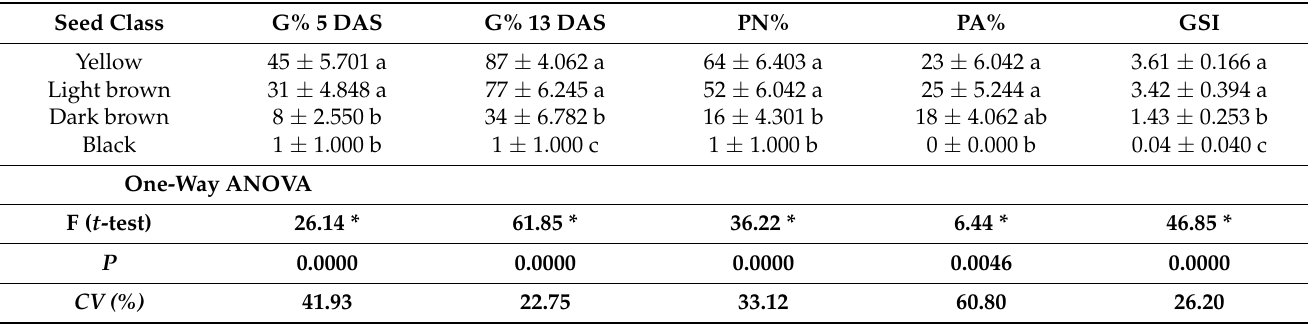
Table 2. Germination percentage at five days after sowing (G% 5 DAS), germination percentage at thirteen days after sowing (G% 13 DAS), percentage of normal seedlings (PN%), percentage of abnormal seedlings (PA%) and GSI (germination speed index) for Pterodon pubescens categorized into different color